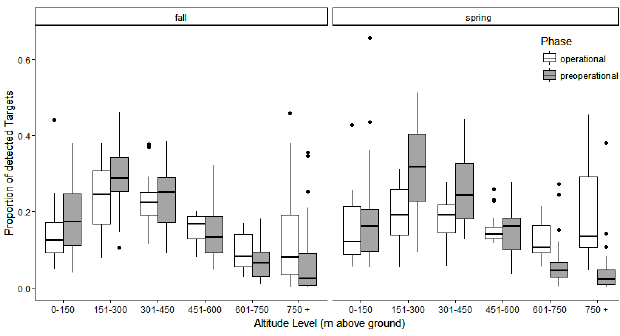
Fig. 5 . The proportion of detected targets for both fall